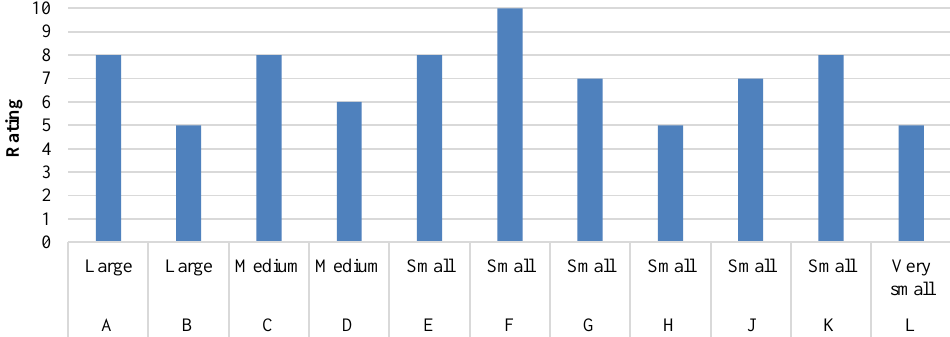
Fig. 2. Ratings of political support for implementing climate and energy related measures from 1 (lowest) to 10